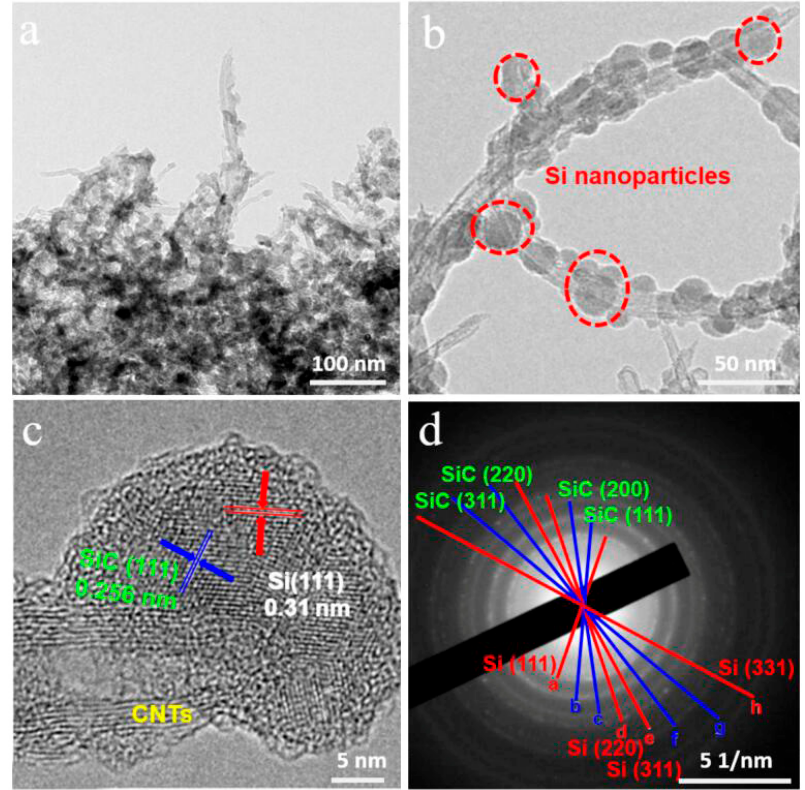
Figure 6. ( a , b ) TEM images of Si/SiC/CNT nanocomposite; ( c ) HRTEM image of